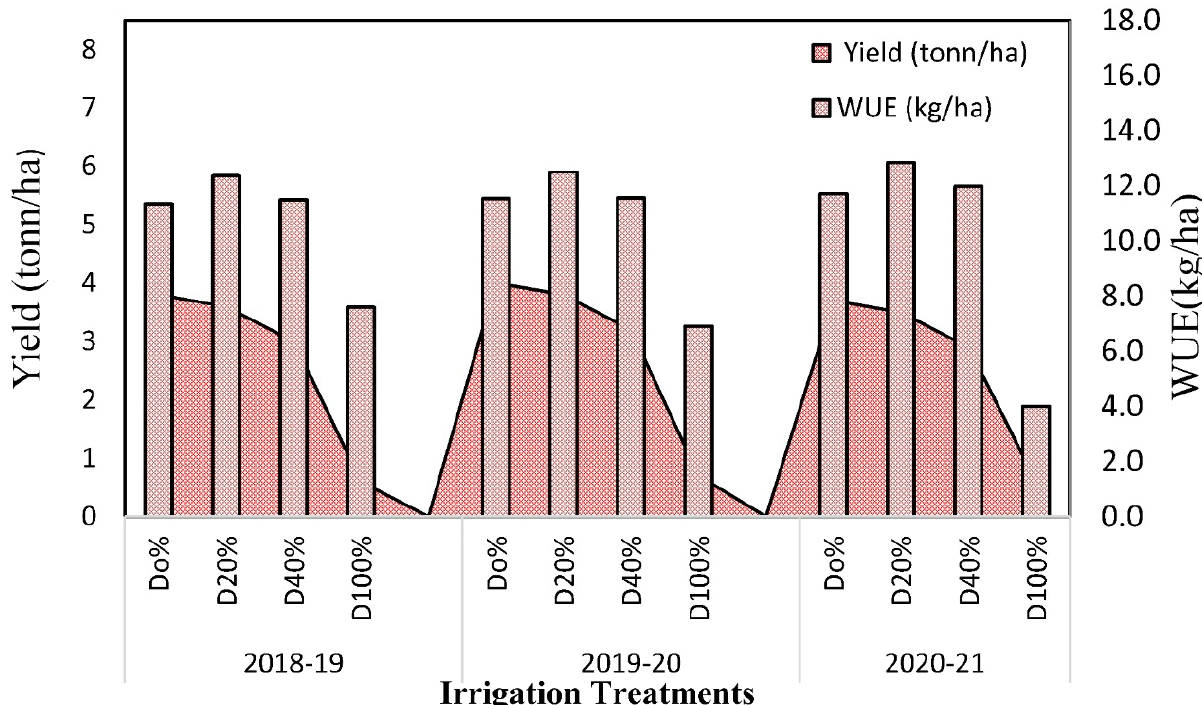
Figure 6. Relationship between WUE and Yield at different level irrigation t reatments during growing season.